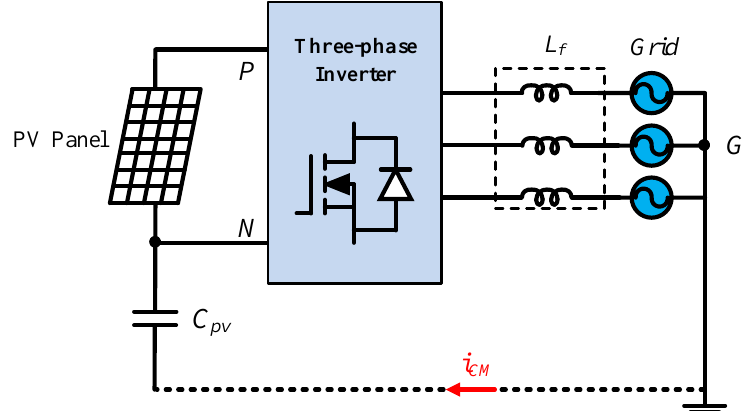
Figure 1. Typical three-phase transformerless VSI configuration using an L -filter.